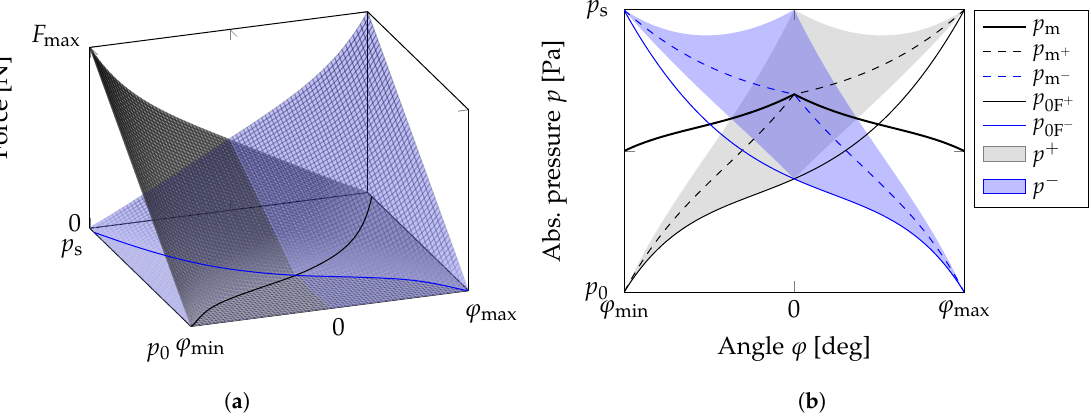
Figure 3. Overlay of two PMA force maps; PMA + colored in black, PMA − colored in blue. ( a ) Overlay of two PMA force maps such that both PMAs are connected at half contraction. Bottom lines are representing the curve of zero PMA force. ( b ) Top view of the left picture; characteristics of the mean pressure p m . The black respectively the blue area are showing the valid pressure ranges for PMA + and PMA − , such that tight ropes can be